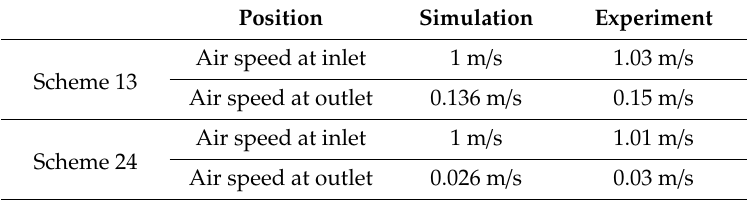
Figure 25. A temperature field change in scheme 24 in the dying minutes. Table 2. Comparison of the air speed at the inlet and outlet in the simulation and the experiment.